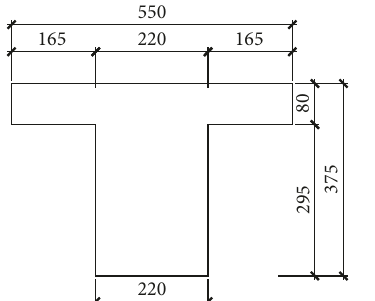
Figure 2: Midspan cross section of model beam (mm).